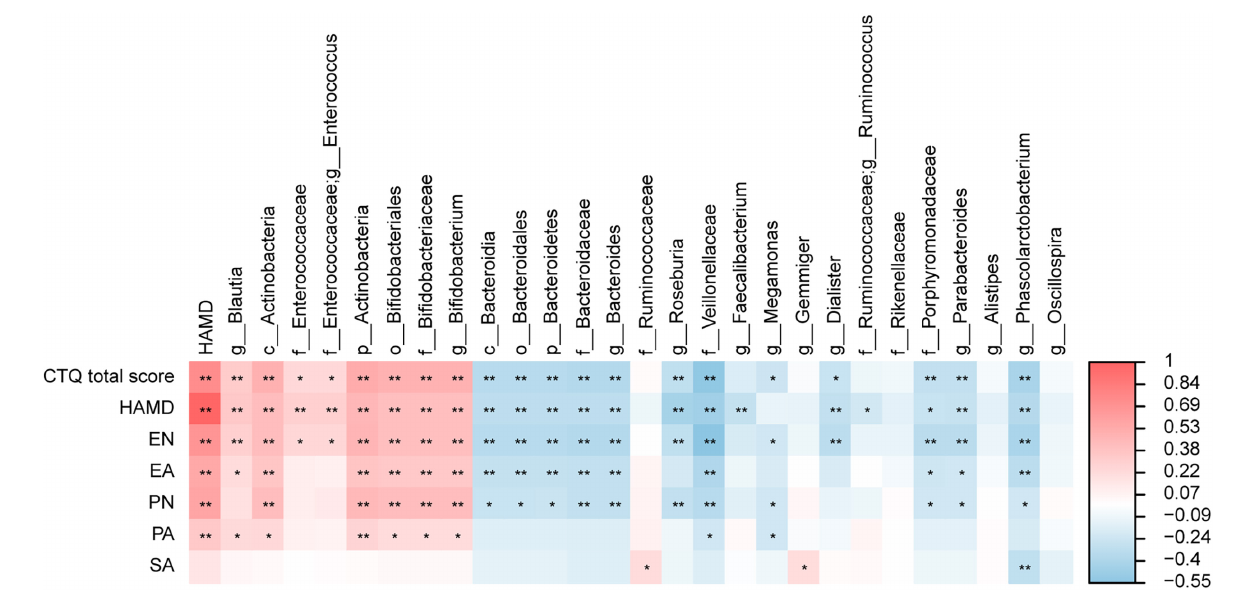
FIGURE 4 | The heatmaps of spearman correlation coefficient matrix between significant different gut microbiota and the score of the HAMD-24 and CTQ-SF. Red indicates positive correlations while blue indicates negative. * P < 0.05, ** P < 0.01.